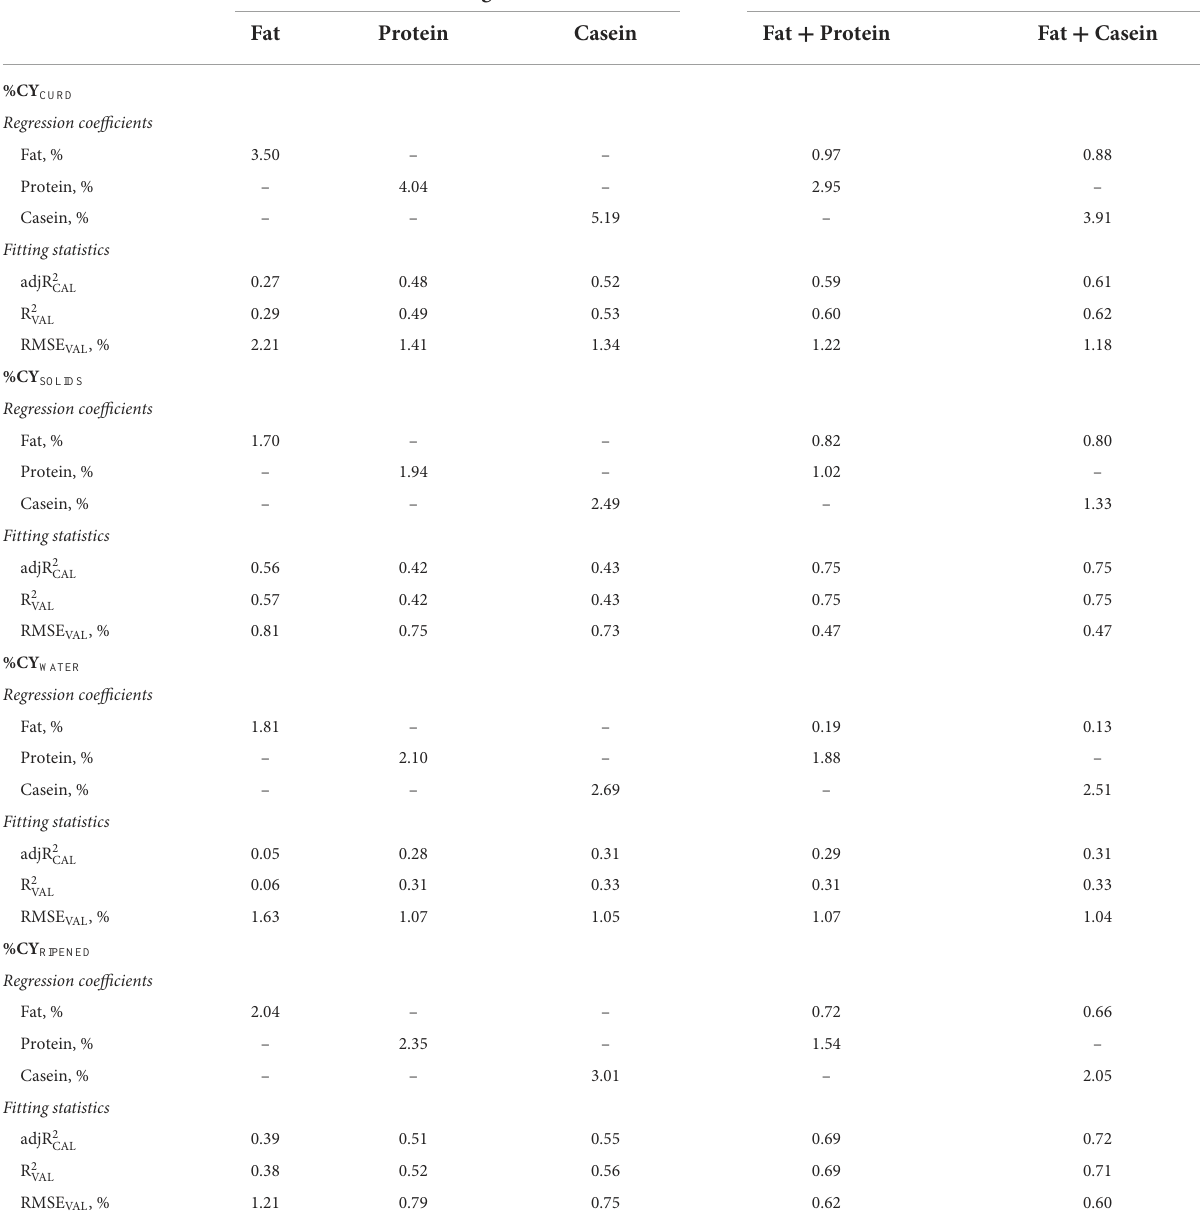
TABLE 2 Regression coefficients and fitting statistics (adjR 2 CAL , R 2 VAL and RMSE VAL ) of predicting fresh curd (%CY CURD ), cheese solids (%CY SOLIDS ), water retained in the curd (%CY WATER ) and ripened cheese (%CY RIPENED ) of models based on fat, protein and total casein content of processed milk. Models with a single nutrient: Models with combination of nutrients: Fat Protein Casein Fat + Protein Fat +